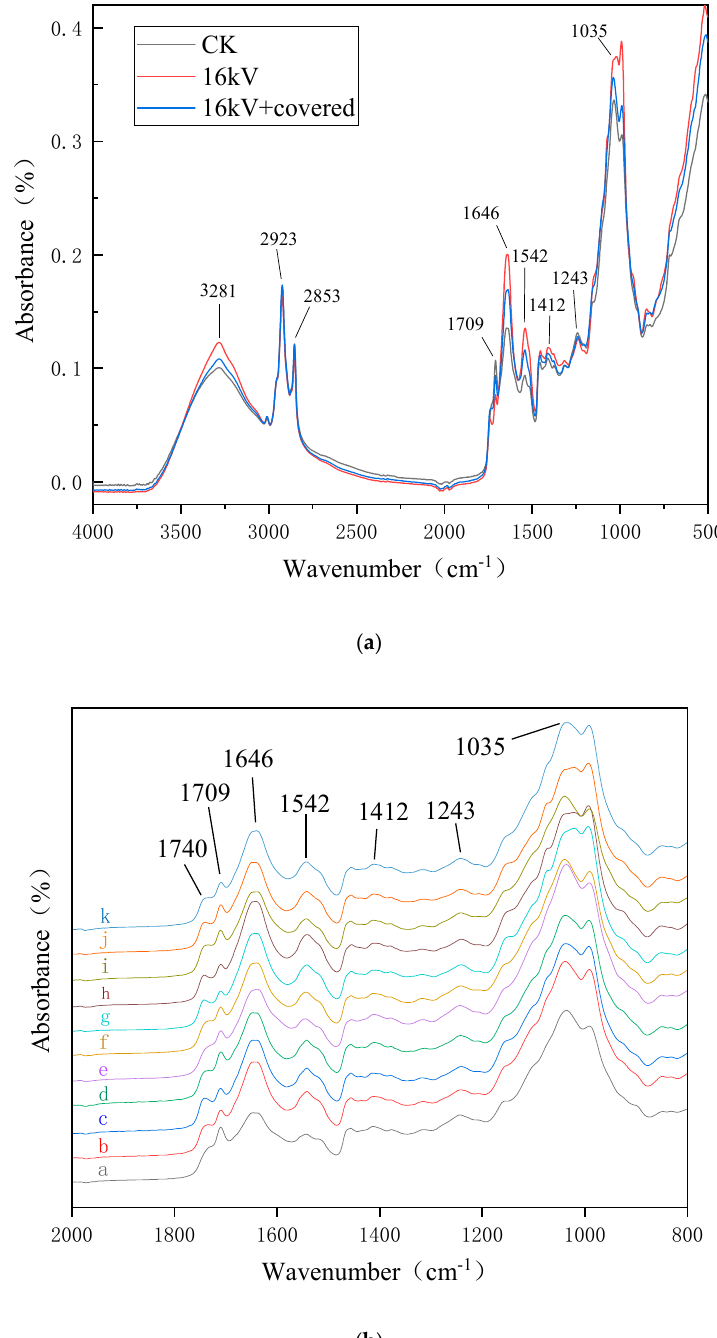
Figure 9. Infrared spectra of naked oat seed coat after HVEF treatment: ( a ) Infrared spectra of naked oat seed coat before and after treatment with 16 kV HVEF; ( b ) Infrared spectra of naked oat seed coat before and after treatment with different voltages, wherein a, b, c, d, e, f, g, h, i, j and k represent CK, 4 kV, 4 kV + covered, 8 kV, 8 kV + covered, 12 kV, 12 kV + covered, 16 kV, 16 kV + covered, 20 kV, 20 kV + covered, respectively.